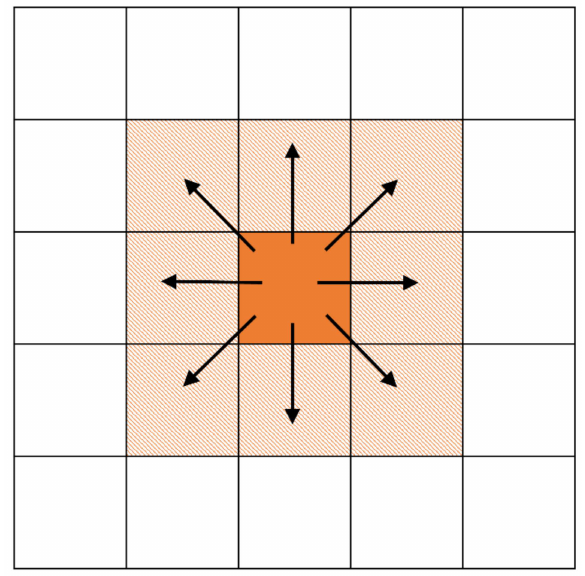
Figure 1. First-order queen contiguity relationship between the spatial units. The numeric-type spatial weight matrix considered in this paper is the numeric threshold distance adjacency matrix. This suggests that the geospatial objects within the specified threshold distance are adjacent, whereas geospatial objects at a distance exceeding the threshold distance are not adjacent. The weight w ij from s j to s i is w ij = (cid:40) 1 , d ij < d T d ij , where d T is the threshold 0, d ij ≥ d T